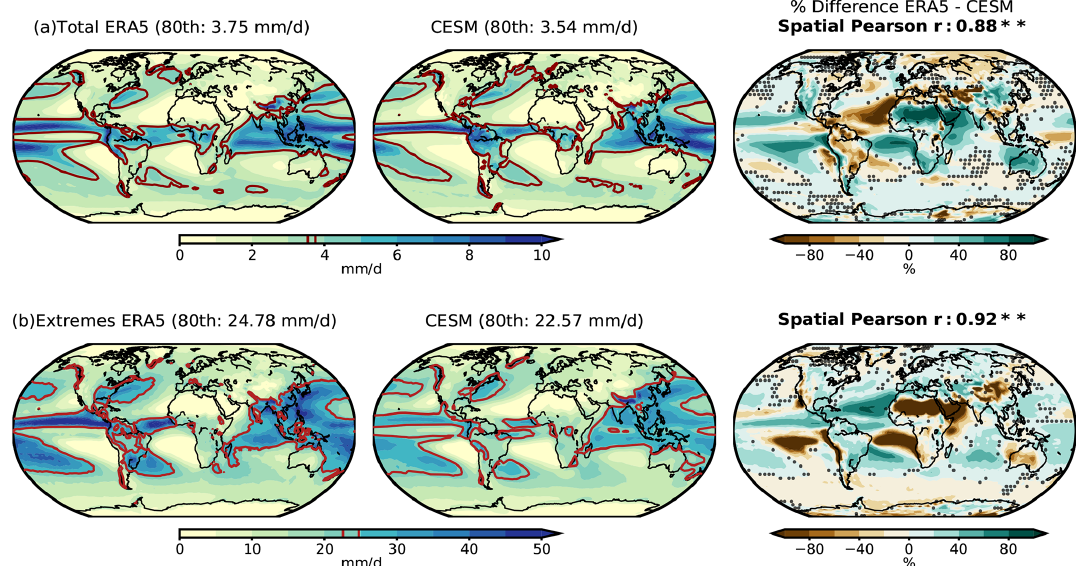
Figure 5. Mean values of ERA5 and CESM, and the percentages of difference between both data sets calculated as (ERA5 − CESM) / ERA5 for (a) the total daily precipitation and (b) the extreme daily precipitation (daily precipitation above the 95th percentiles relative to 1979– 2008CE distributions). The brown line indicates the 80th percentile level to discern wet regions (above the 80th percentile) from others. Dotted regions in the difference plots indicate where the distributions of total or extreme precipitation are statistically similar at the 99% confidence interval based on the M-W U tests. Pearson r coefficients between the spatial mean values of ERA5 and CESM are denoted in bold on the difference plots accompanied with ** when the r values are statistically significant at the 99% confidence